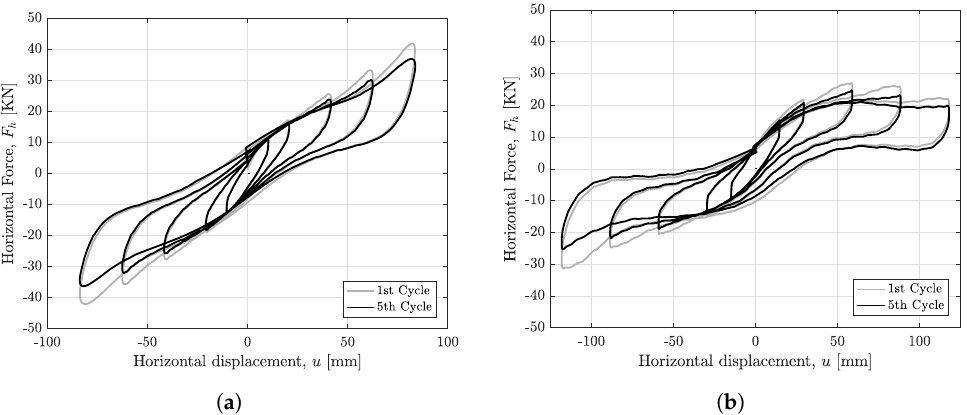
Figure 2. Load-displacement curves for the experimentally tested bearings: ( a ) 08RL_09S under 4 MPa vertical pressure; ( b ) 27RL_22S under 4 MPa vertical pressure.